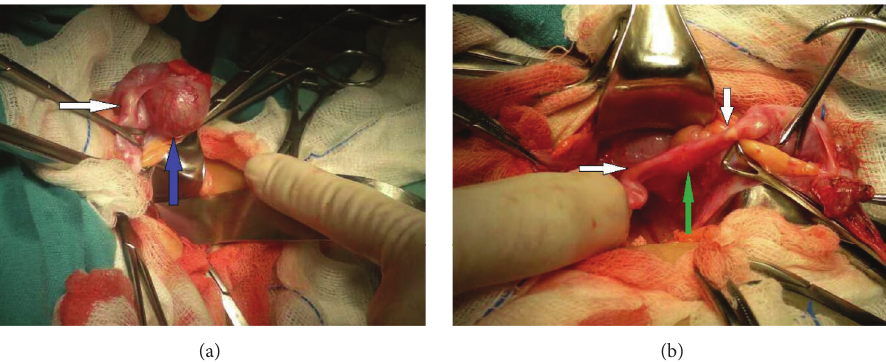
Figure 3: Intraoperative findings of laparotomy. (a) Paraovarian mass (blue arrow) and right tube (white arrow). Right ovary is located behind tumor. (b) After tumor excision, left and right tubes (white arrows) and normal uterus (green arrow) are shown.